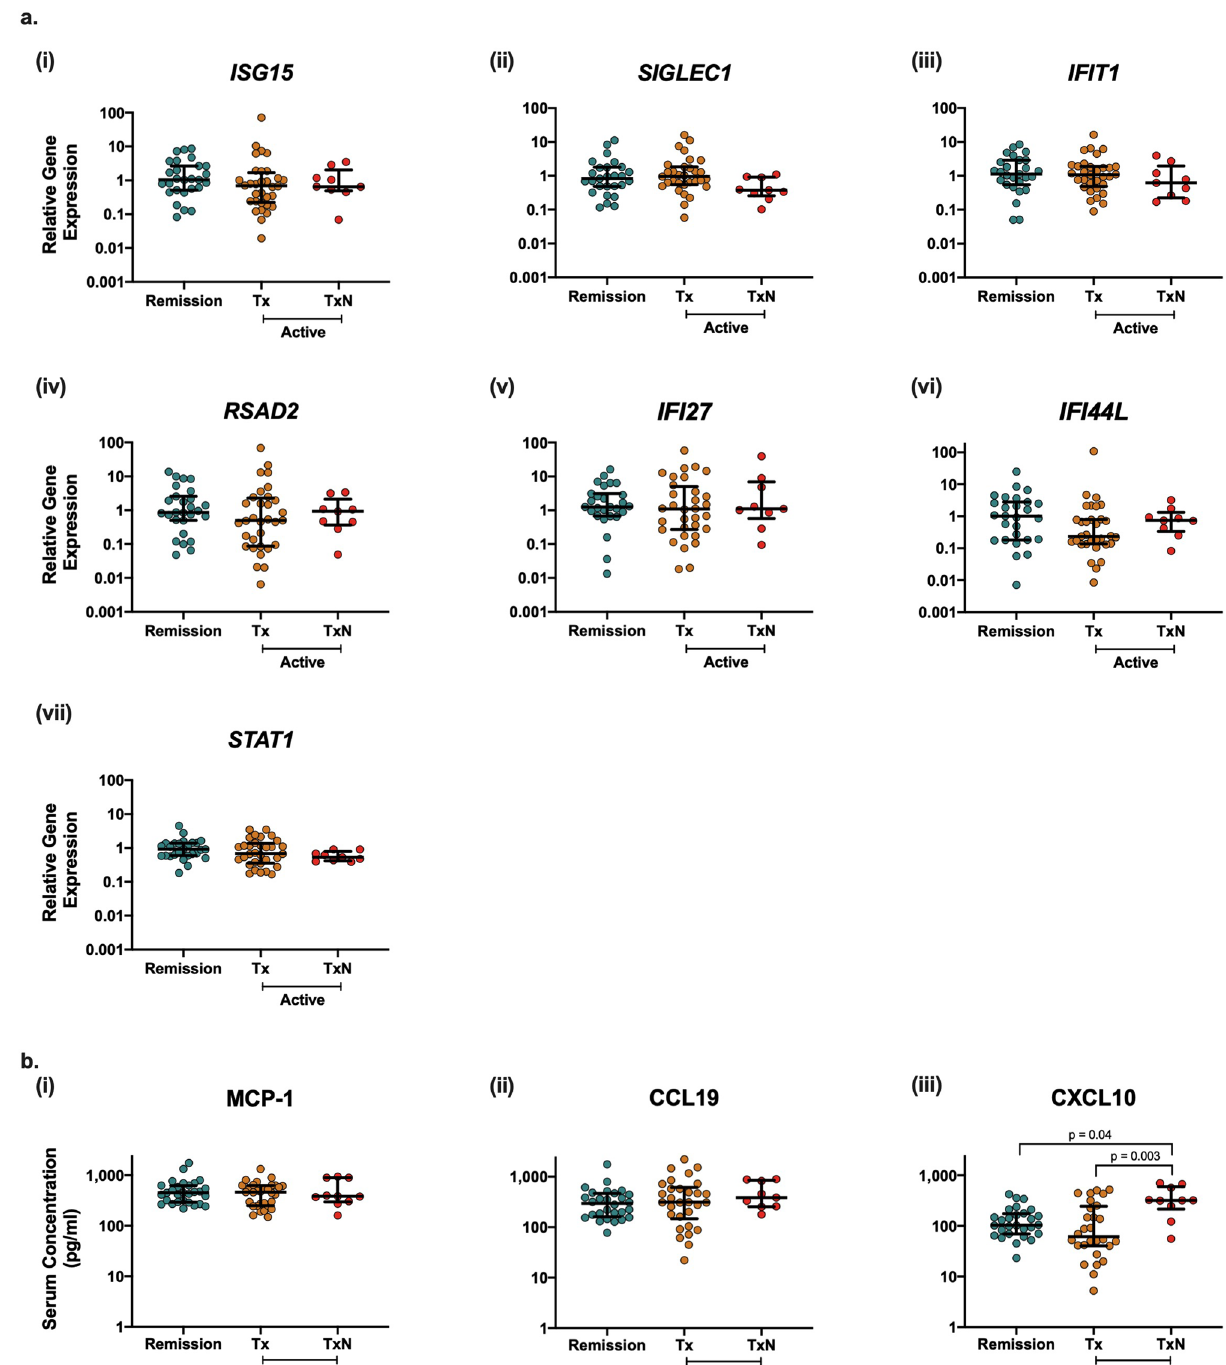
Figure 3. The effects of immunosuppressive treatment on type I IFN regulated gene expression and protein expression. Whole blood samples were obtained from treated AAV remission patients (n = 27), treated AAV active patients (Tx; n = 31) and treatment naïve AAV active patients (TxN; n = 10). qPCR was used to quantify the expression of seven IRGs ( a ); IRGs (i) ISG15 , (ii) IFIT1, (iii) SIGLEC1, (iv) RSAD2 (v) IFI27, (vi) IFI44L and (vii) STAT1 . Gene expression data is shown relative to the expression of the endogenous control gene RPL27 and normalised to the median expression of the healthy control samples (2 −ΔΔCT ). Matching serum samples were collected from AAV remission (n = 29), treated AAV active patients (Tx; n = 31) and treatment naïve AAV active patients (TxN; n = 10). ( b ) Serum concentrations of circulating (i) MCP-1, (ii) CCL19 and (iii) CXCL10 were measured using ELISAs. Whole horizontal lines represent the median and IQR of each cohort and statistical analysis was performed using One-Way ANOVA with Dunn’s multiple comparison